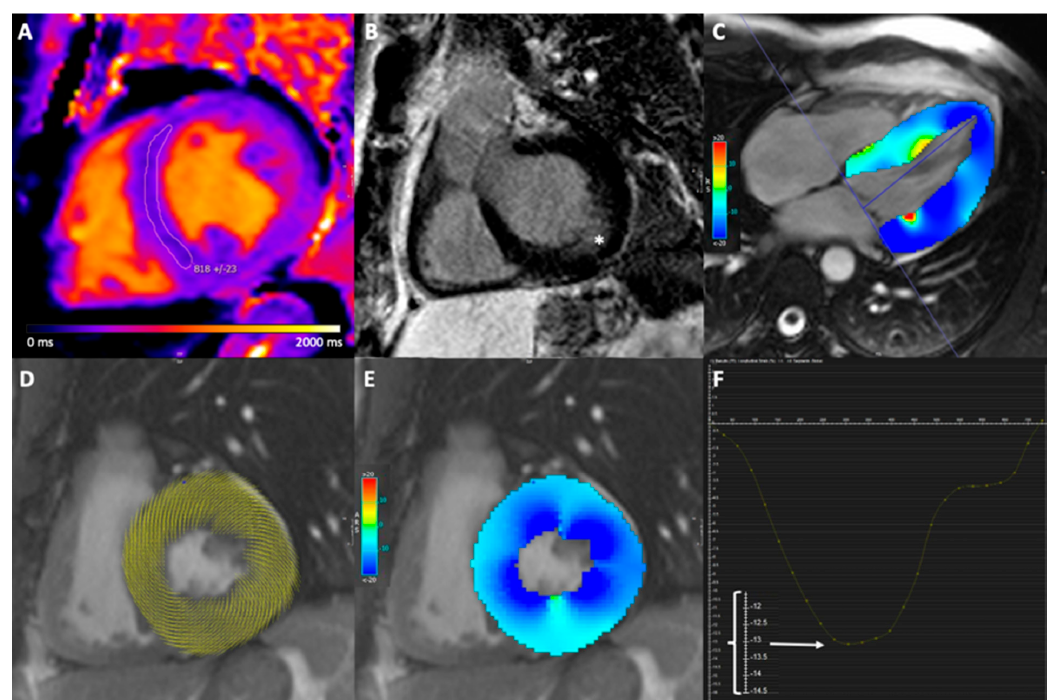
Figure 1. Imaging example including native T1 map, LGE image and strain images. Cardiovascular magnetic resonance images of a 38-year-old male with Fabry disease. Midventricular short-axis native T1 map ( A ) demonstrates reduced septal native T1 time, and basal short-axis late gadolinium enhanced (LGE) image ( B ) demonstrates intramural LGE at the inferior lateral wall (white asterisk). Short-axis CINE steady state free precession (SSFP) image with circumferential myocardial strain analysis points ( D ) and color-coded myocardial circumferential strain map ( E ). Long-axis CINE SSFP image with color-coded myocardial longitudinal strain map ( C ). Global longitudinal strain was − 13.2%, as the enlarged scale on the Y-axis showed ( F ).